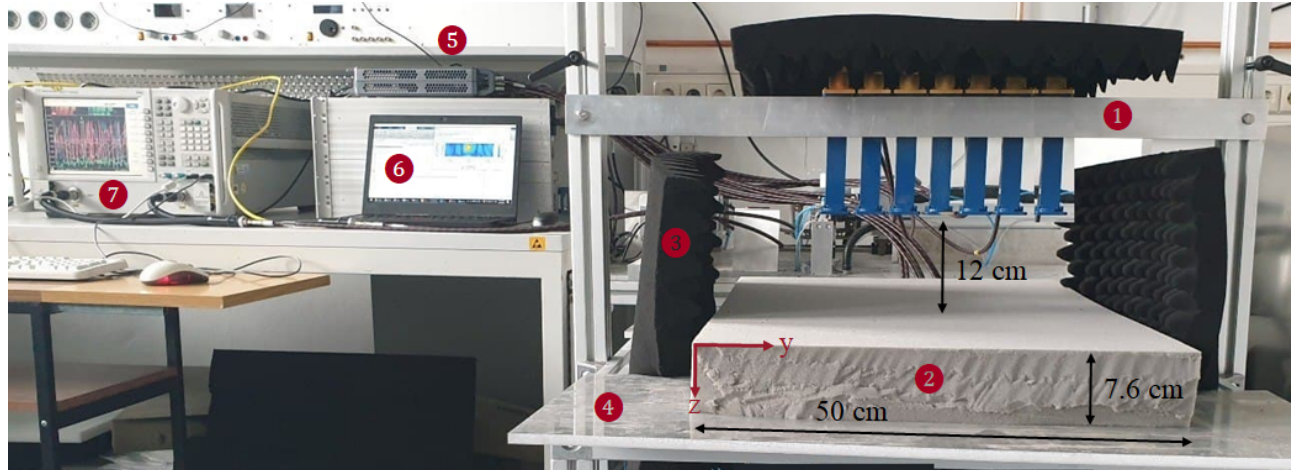
Figure 11. Prototype of MWT sensor array used in this study to generate measurement data. The MWT sensor configuration consists of 7 X-band open-ended waveguide antennas, indicated by Tag 1. The polymer foam is shown by Tag 2 and surrounded by absorbers as shown by Tag 3. The flexible PEC plate is shown by Tag 4. To acquire the measurement the solid switch, PC and VNA are used as shown by Tags 5, 6, and 7, respectively. This system is developed at KIT, Germany and will be integrated with the HEPHAISTOS technology in the final stage.